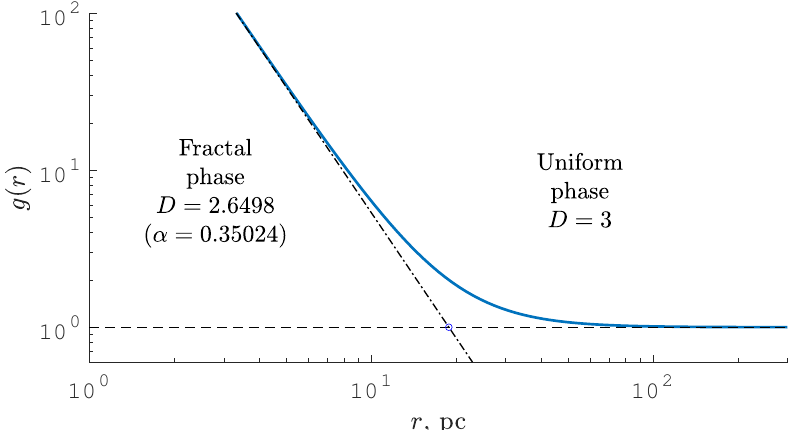
Figure 6. Structure function with the parameters from Figure 5A. The dashed-dotted line corresponds to the fractal phase of the mesofractal with fractal dimension D = 3 − α . The dashed line corresponds to the uniform phase having an exponential distribution. Crossover point r 0 ≈ 20 pc is is defined by the intersection of two